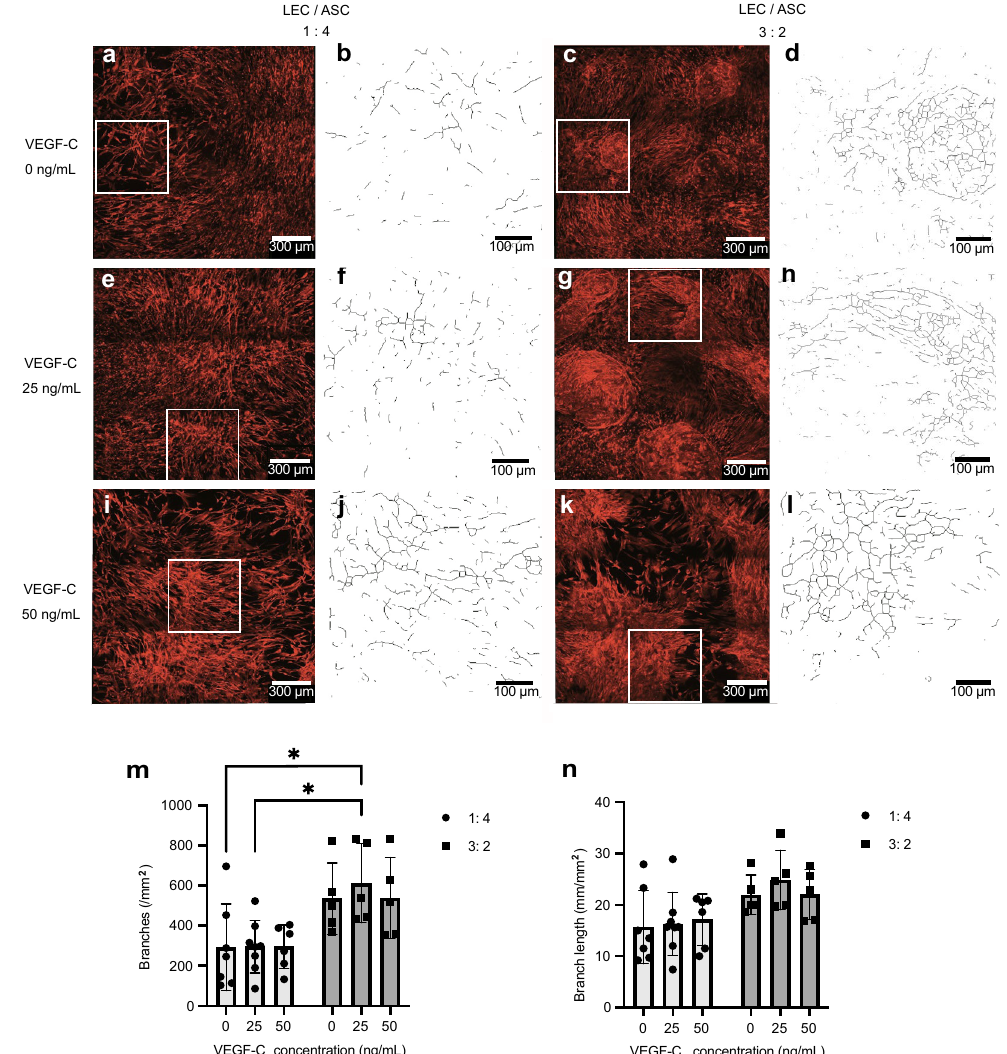
Figure 2. Effects of cell ratio and vascular endothelial growth factor-C (VEGF-C) concentration on the mesh pattern by lymphatic endothelial cells (LECs) co-cultured with adipose-derived stem cells (ASCs). ( a–l ) Representative images of LECs co-cultured with ASCs and immunostained for podoplanin (a glycoprotein expressed by LECs). The LECs were cultured in medium containing 0 ng/mL VEGF-C ( a – d ), 25 ng/mL VEGF-C ( e – h ) or 50 ng/mL VEGF-C ( i – l ), and the ratio of LECs to ASCs was either 1:4 ( a , b , e , f , i , j ) or 3:2 ( c , d , g , h , k , l ). High-power images of ( a , c , e , g , i , k ) which were skeletonized by ImageJ software to evaluate branches and branch lengths are shown in ( b , d , f , h , j , l ). LECs co-cultured with ASCs at a ratio of 1:4 in 0 ng/mL VEGF-C or 25 ng/mL VEGF-C generated elongated structures but did not form ‘islands’ ( a , b , e , f ). Similar results were obtained when LECs were co-cultured with ASCs at a ratio of 1:4 in 50 ng/mL VEGF-C, although the LEC mesh pattern was denser than that obtained in the lower concentrations of VEGF-C ( i , j ). LECs co-cultured with ASCs at a ratio of 3:2 in 0 ng/mL VEGF-C formed island-like structures with a dense LEC mesh pattern ( c , d ). LECs co-cultured with ASCs at a ratio of 3:2 in 25 ng/mL VEGF-C or 50 ng/mL VEGF-C formed more prominent island-like structures containing a dense and fine LEC mesh pattern ( g , h , k , l ). ( m ) Density of branches in the LEC mesh pattern (number of branches per mm 2 ). Significantly more branches were observed for a LEC/ASC ratio of 3:2 than for a ratio of 1:4 (P < 0.0001, two-way analysis of variance [ANOVA]). However, the concentration of VEGF-C had no significant effect on junction formation (P = 0.83, two-way ANOVA). Pairwise comparisons showed that branch density in the 3:2 ratio/25 ng/mL VEGF-C group was significantly higher than that in the 1:4 ratio/0 ng/mL VEGF-C group or the 1:4 ratio/25 ng/mL VEGF-C group (P < 0.05). All conditions were quantified and compared. Non-significant differences were not denoted on the graphs. The data are presented as the mean ± standard deviation (n = 8 per group). * P < 0.05. ( n ) LEC mesh pattern branch length (mm/mm 2 ). Branch length was longer for a LEC/ASC ratio of 3:2 than for a ratio of 1:4 (P = 0.002, two- way ANOVA). However, VEGF-C had no significant effect on branch length (P = 0.76, two-way ANOVA). All conditions were quantified and compared. Non-significant differences were not denoted on the graphs. The data are presented as the mean ± standard deviation (n = 8 per